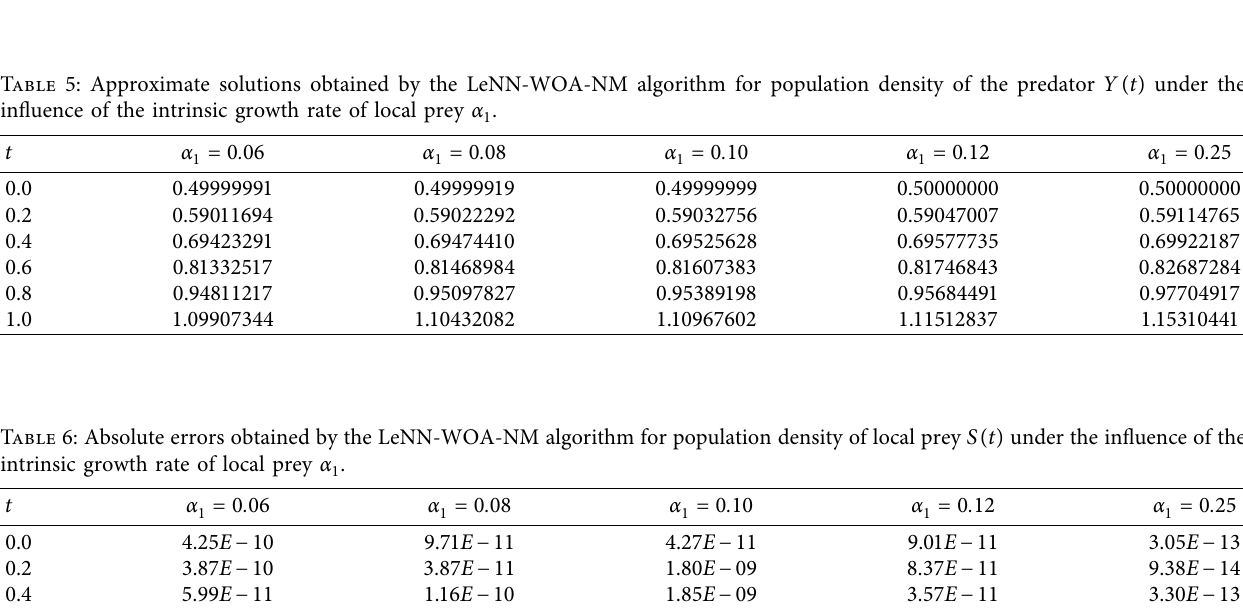
Table 5: Approximate solutions obtained by the LeNN-WOA-NM algorithm for population density of the predator Y ( t ) under the influence of the intrinsic growth rate of local prey α